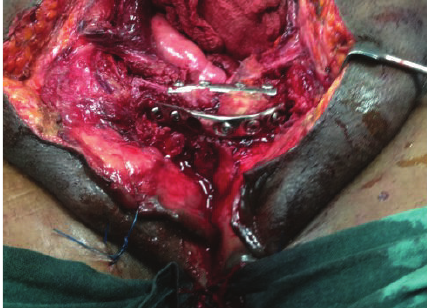
Figure 4: Image showing plated pelvic fracture after reduction and repair of bladder and pelvic